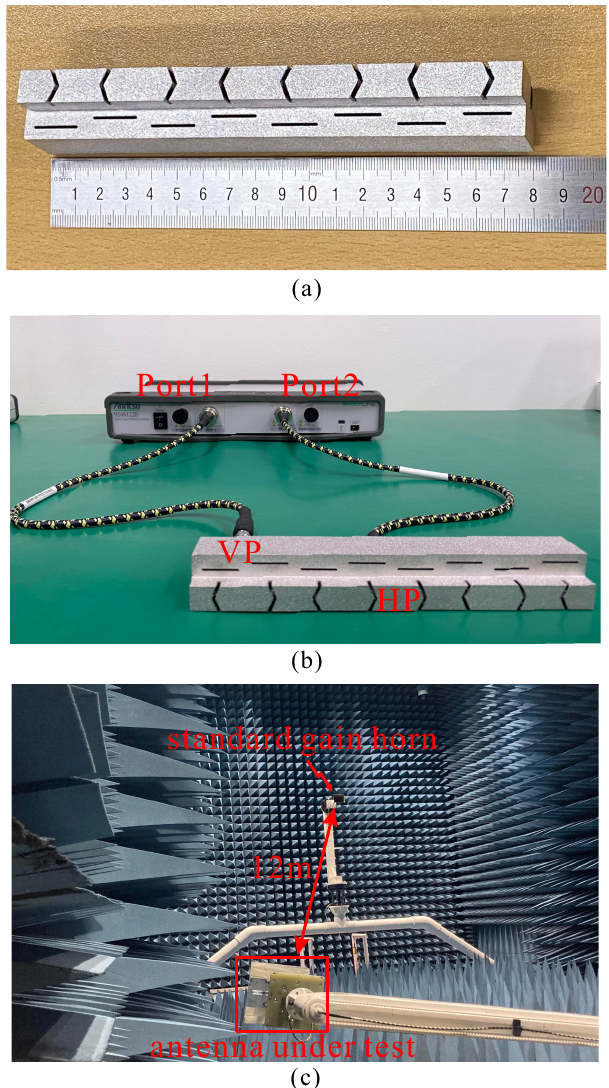
Figure 10. ( a ) Photograph of the fabricated dual-polarized antenna array. ( b ) Two-port vector network analyzer to measure the S-parameters. ( c ) Far-field measurement setup in an anechoic chamber. With Port 1 connected to the VP array and Port 2 connected to the HP array, the scattering parameters for reflection ( S 11 or S 22 ) and transmission ( S 12 or S 21 ) were recorded. Additionally, the gains and radiation patterns were examined inside an RF anechoic cham- ber with a far-field antenna measurement setup as shown in Figure 10c. The chamber had dimensions of 16 × 11 × 9.5 m and a measurable frequency bandwidth of 400–24.5 GHz, with a standard gain horn source and the antenna under test (AUT) installed 12 m